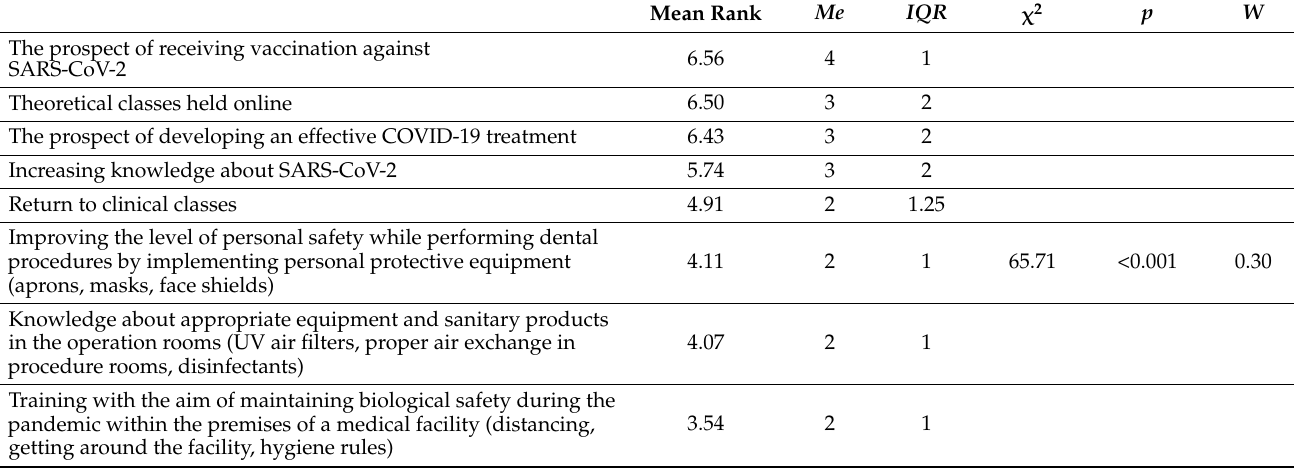
Table 2. Pre-clinical education: Friedman’s analysis comparing the influences of implemented preventive activities on stress perception among students of dentistry at JUMC in their first and second years of study during the COVID-19 pandemic. Legend: Me —median, IQR —interquartile